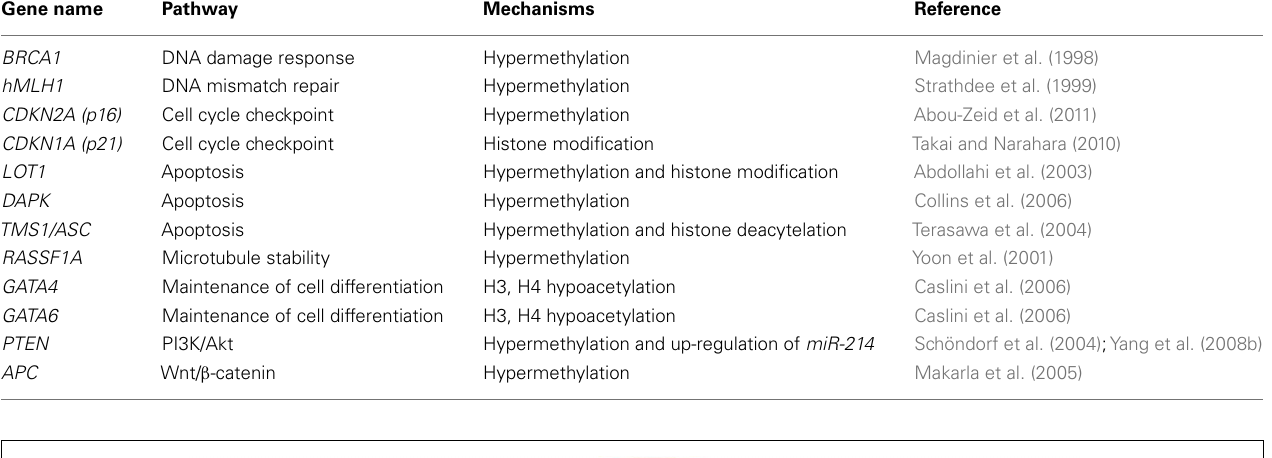
Table 1 |Tumor suppressor genes (TSGs) regulated by epigenetic mechanisms in ovarian cancer.